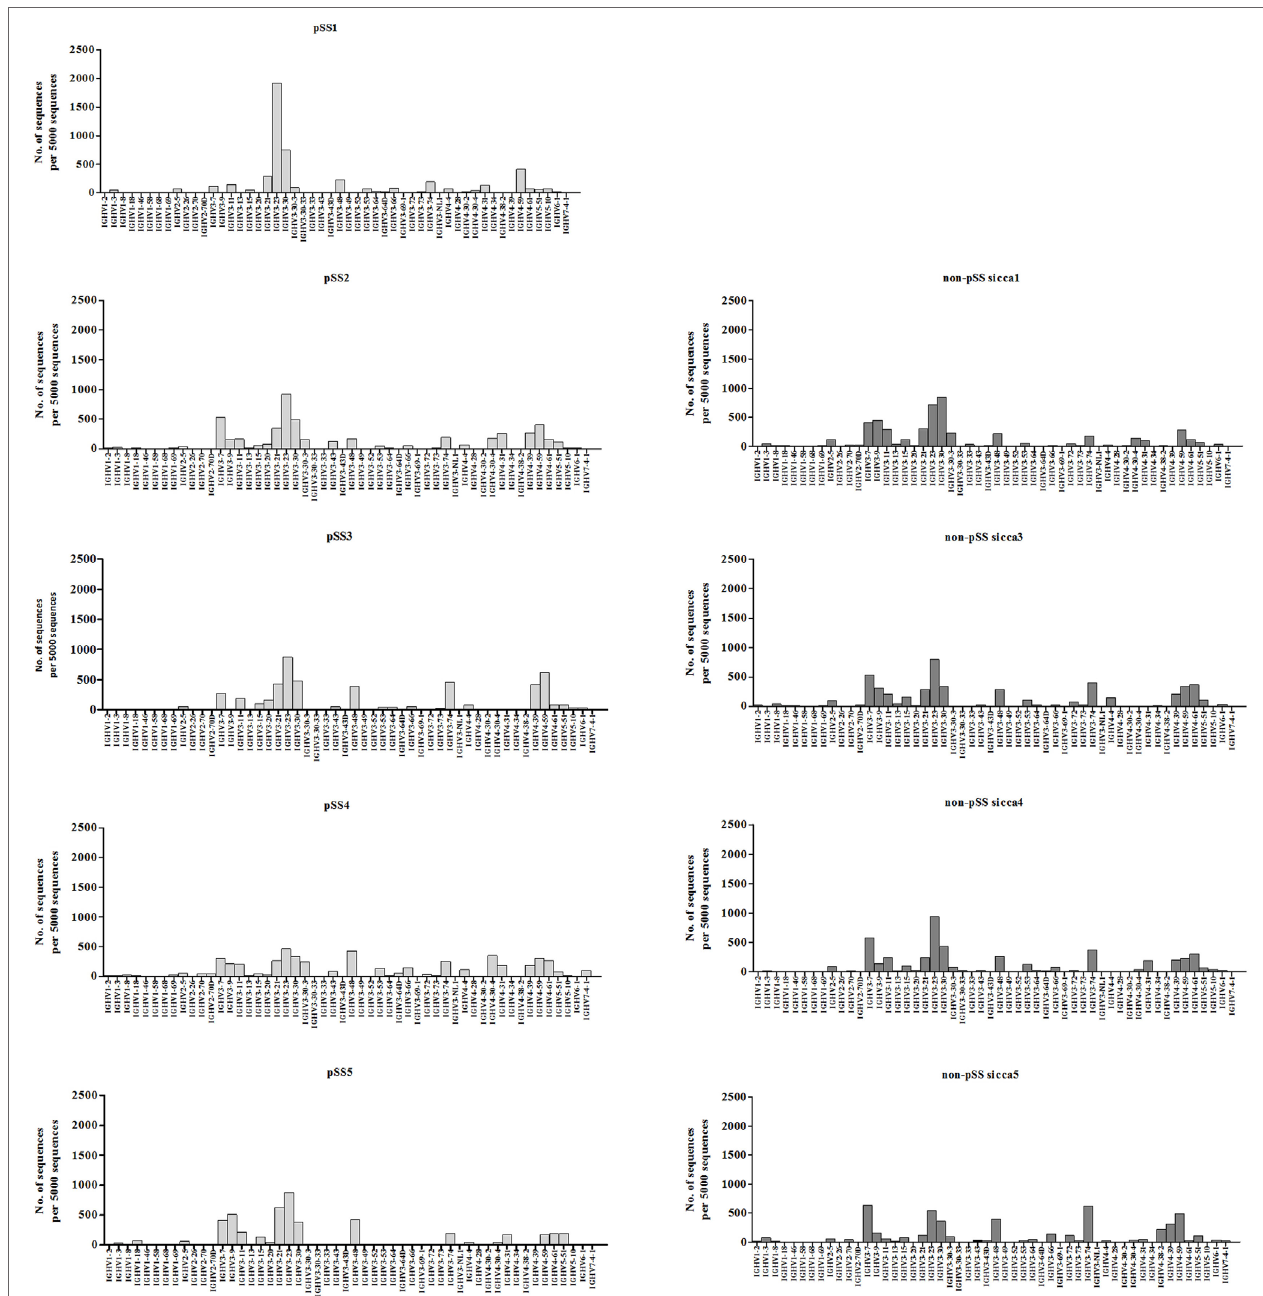
FigUre 1 | Percentage of IGVH gene usage in the parotid gland biopsies of pSS patients compared to those from non-pSS sicca